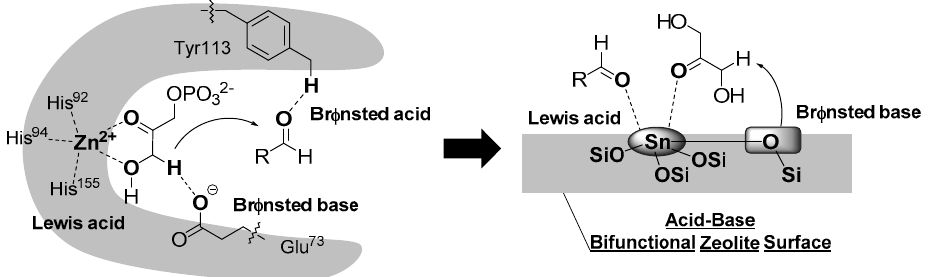
Figure 1. Acid-base cooperative catalysis inspired by a three-dimensional enzyme architecture.